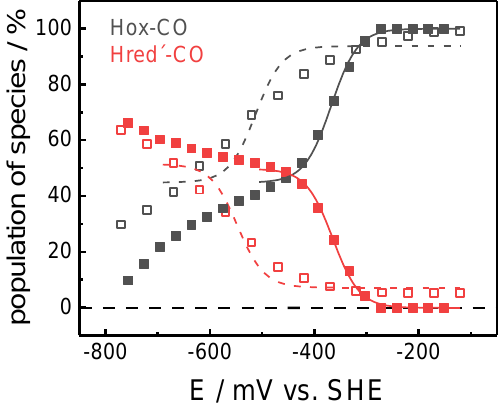
Figure 3. Hox-CO → Hred´-CO redox transition as function of potential. The conversion of Hox-CO (black symbols) to Hred´-CO (red symbols) was probed at pH 5 (solid symbols) or pH 8 (open symbols). The lines show fit curves using the Nernst equation. At pH 5 a midpoint potential (E m ) of − 360 ± 10 mV was determined, while at pH 8, E m was shifted to − 530 ± 30 mV. The larger error for the E m value at pH 5 was due to the increasing formation of Hsred at the expense of Hred´-CO at low potentials, which caused further changes in the Hox-CO and Hred´-CO populations (compare Figure 2).